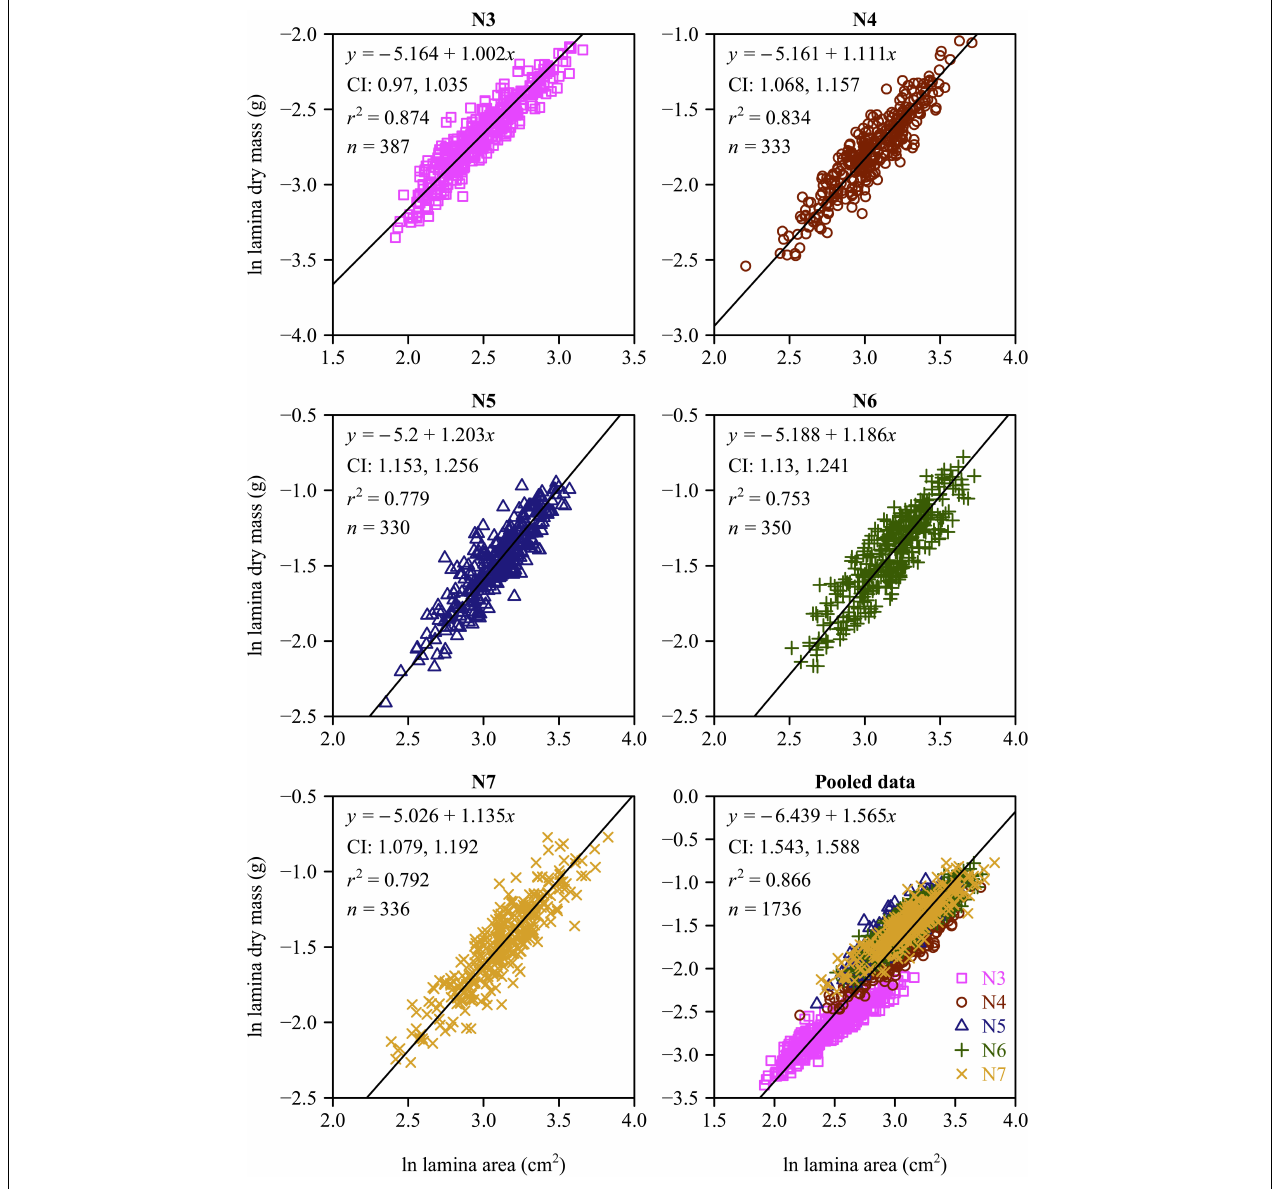
FIGURE 5 | Fitted scaling relationships between lamina dry mass and lamina surface area for the five leaf-age groups. The small open circles represent the log-transformed values of lamina dry mass vs. lamina surface area; the red straight lines represent the regression lines; CI represents the 95% confidence intervals of the slope; r 2 is the coefficient of determination; and n is the sample